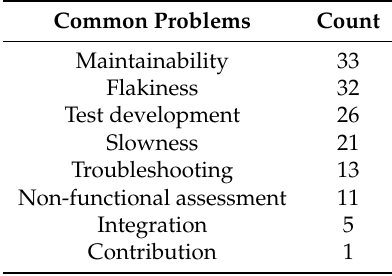
Table A21. 7.a. What are the common problems you face when testing with